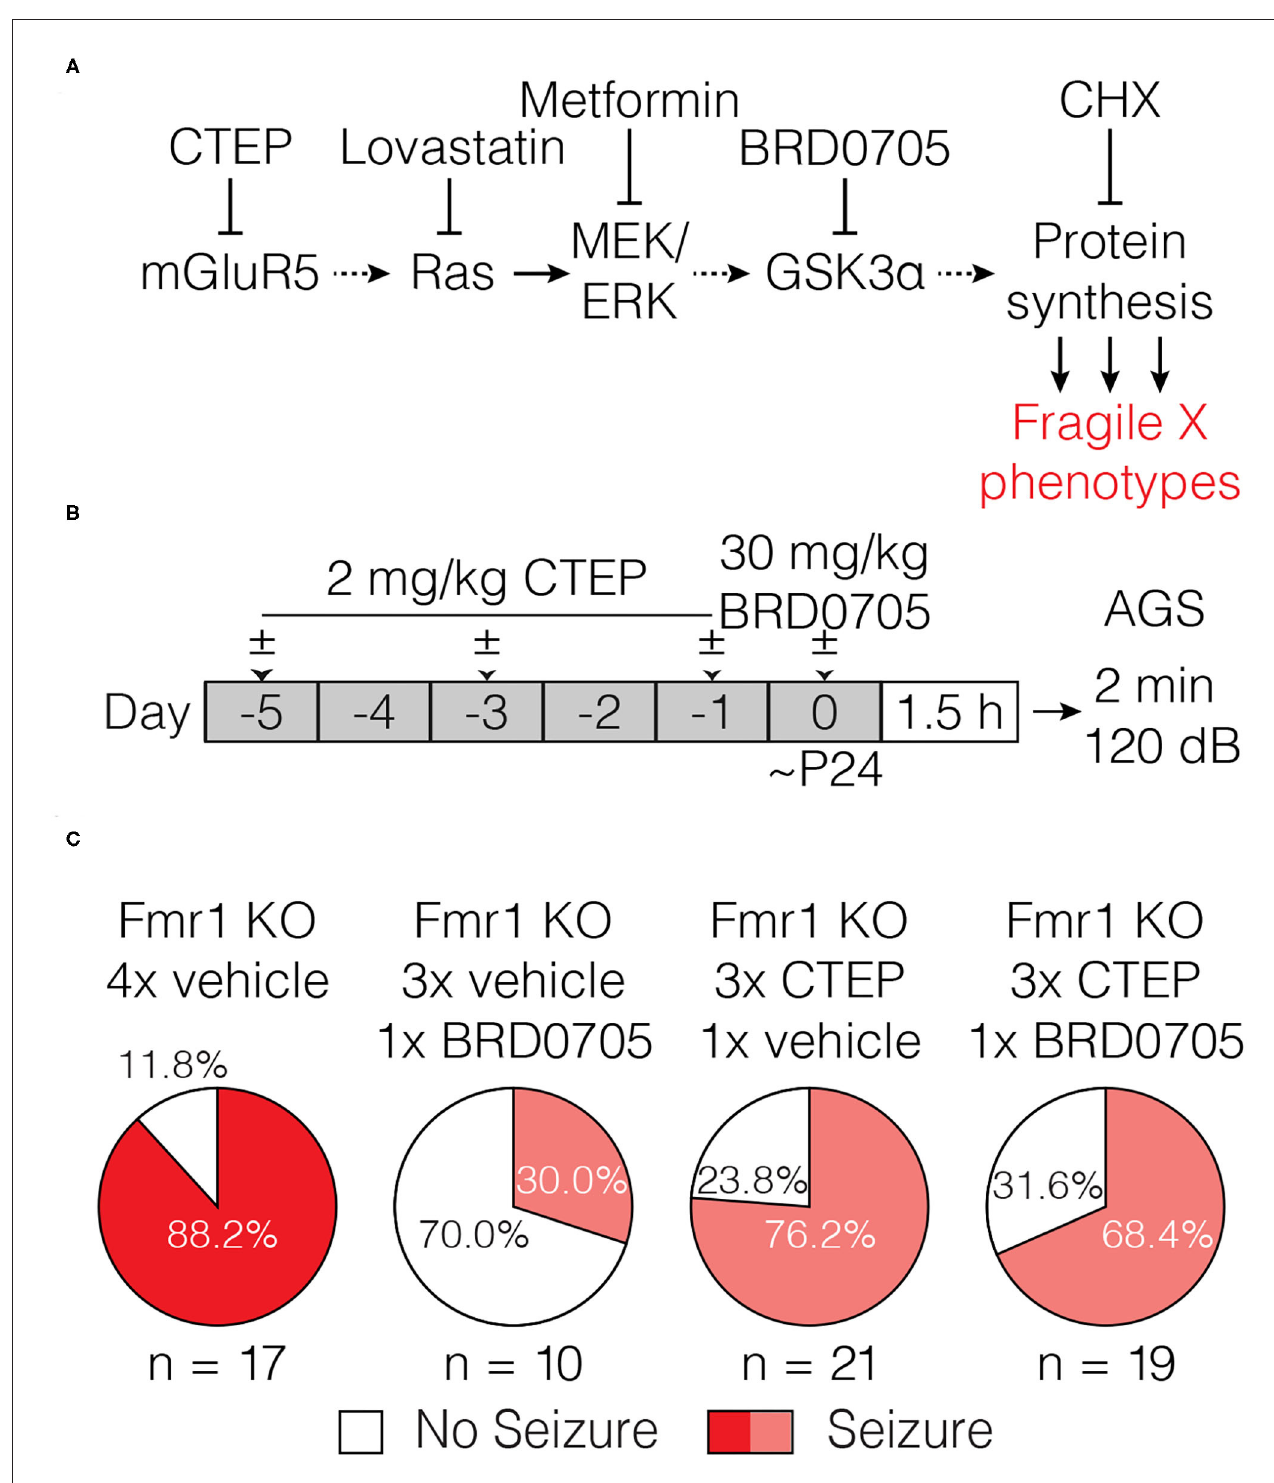
FIGURE 5 | Inhibiting GSK3 α does not overcome audiogenic seizure treatment resistance induced by chronic CTEP. (A) Some elements of the signaling pathway that couples mGluR5 to protein synthesis. AGS susceptibility in fragile X can be corrected by the protein synthesis inhibitor CHX and by compounds acting at several different nodes in this pathway, including GSK3 α . (B) Schematic shows drug dosing schedule and AGS experimental design. (C) Chronic (3 doses over 5 days) treatment with 2.0 mg/kg CTEP followed by a vehicle injection does not alter Fmr1-KO audiogenic seizure susceptibility (two-tailed Fisher’s exact test: Fmr1-KO 4x vehicle vs. Fmr1-KO 3x CTEP + 1x vehicle p = 0.4267). A single injection of 30 mg/kg BRD0705 normalizes audiogenic seizure susceptibility in Fmr1-KO mice but has no effect on seizure incidence in Fmr1-KO mice treated with chronic (3 doses over 5 days) 2.0 mg/kg CTEP (two-tailed Fisher’s exact test: Fmr1-KO 4x vehicle vs. Fmr1-KO 3x vehicle + BRD0705 p = 0.0036; two-tailed Fisher’s exact test: Fmr1-KO 4x vehicle vs. Fmr1-KO 3x CTEP + BRD0705 p = 0.2357).